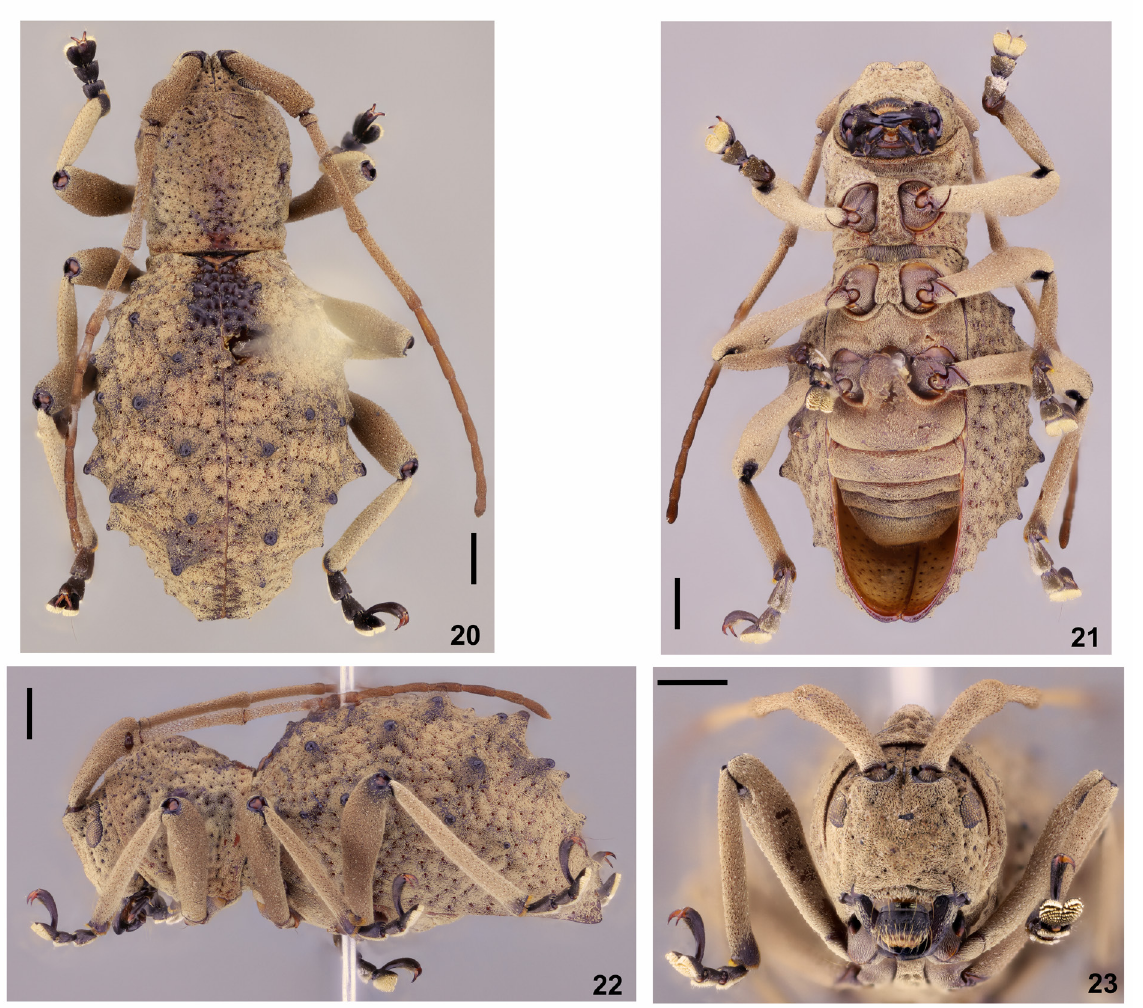
Figs 20–23. Phrynidius guifarroi sp. nov., holotype, ♀ (RBINS 34.248). 20 . Habitus, dorsal view. 21 . Habitus, ventral view. 22 . Habitus, lateral view. 23 . Head, frontal view. Scale bars = 1.0